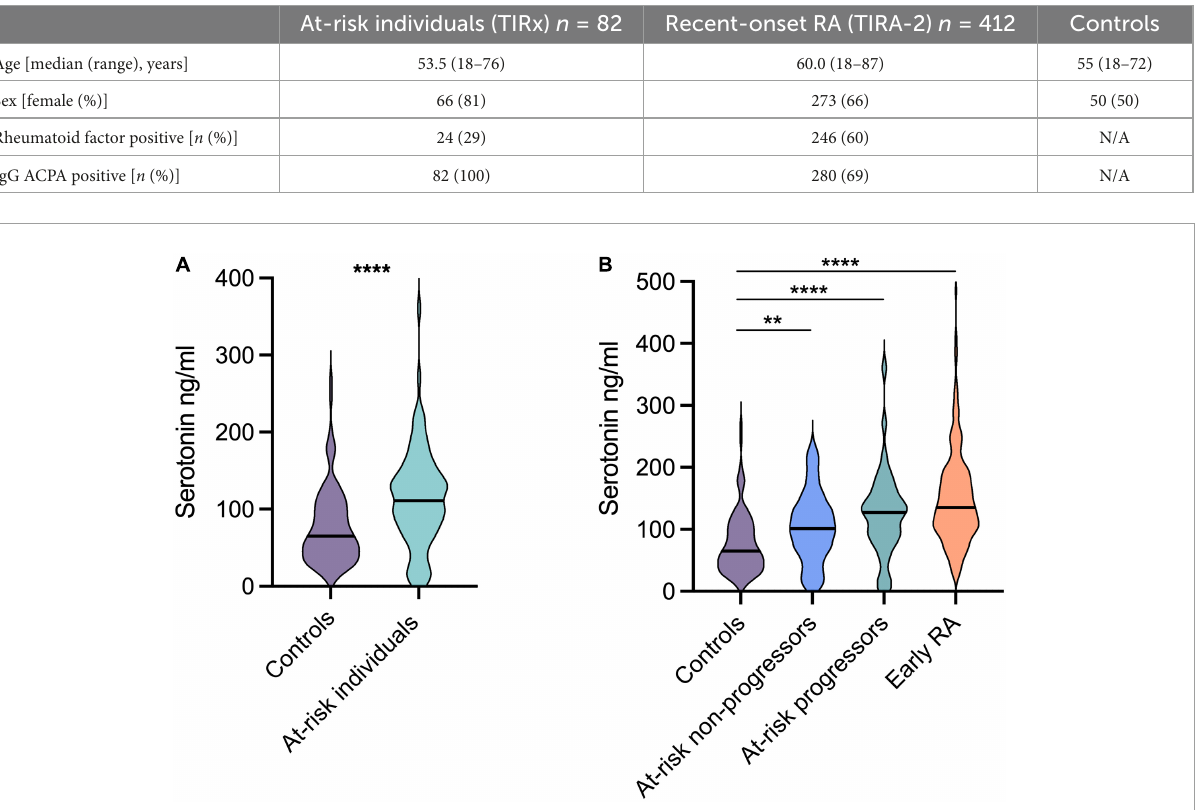
FIGURE1 Serotonin levels in at-risk individuals and patients with early rheumatoid arthritis (RA). (A) Compared to healthy controls, the serotonin levels were significantly higher in at-risk individuals (median 65 ng vs. 111 ng/ml). (B) Patients with early RA had significantly higher levels (median 135 ng/ml) compared to healthy controls (median 65 ng/ml). The levels were comparable between at-risk individuals progressing and not progressing to arthritis (median 127 ng/ml and 102 ng/ml respectively). **** p < 0.0001, ** p =